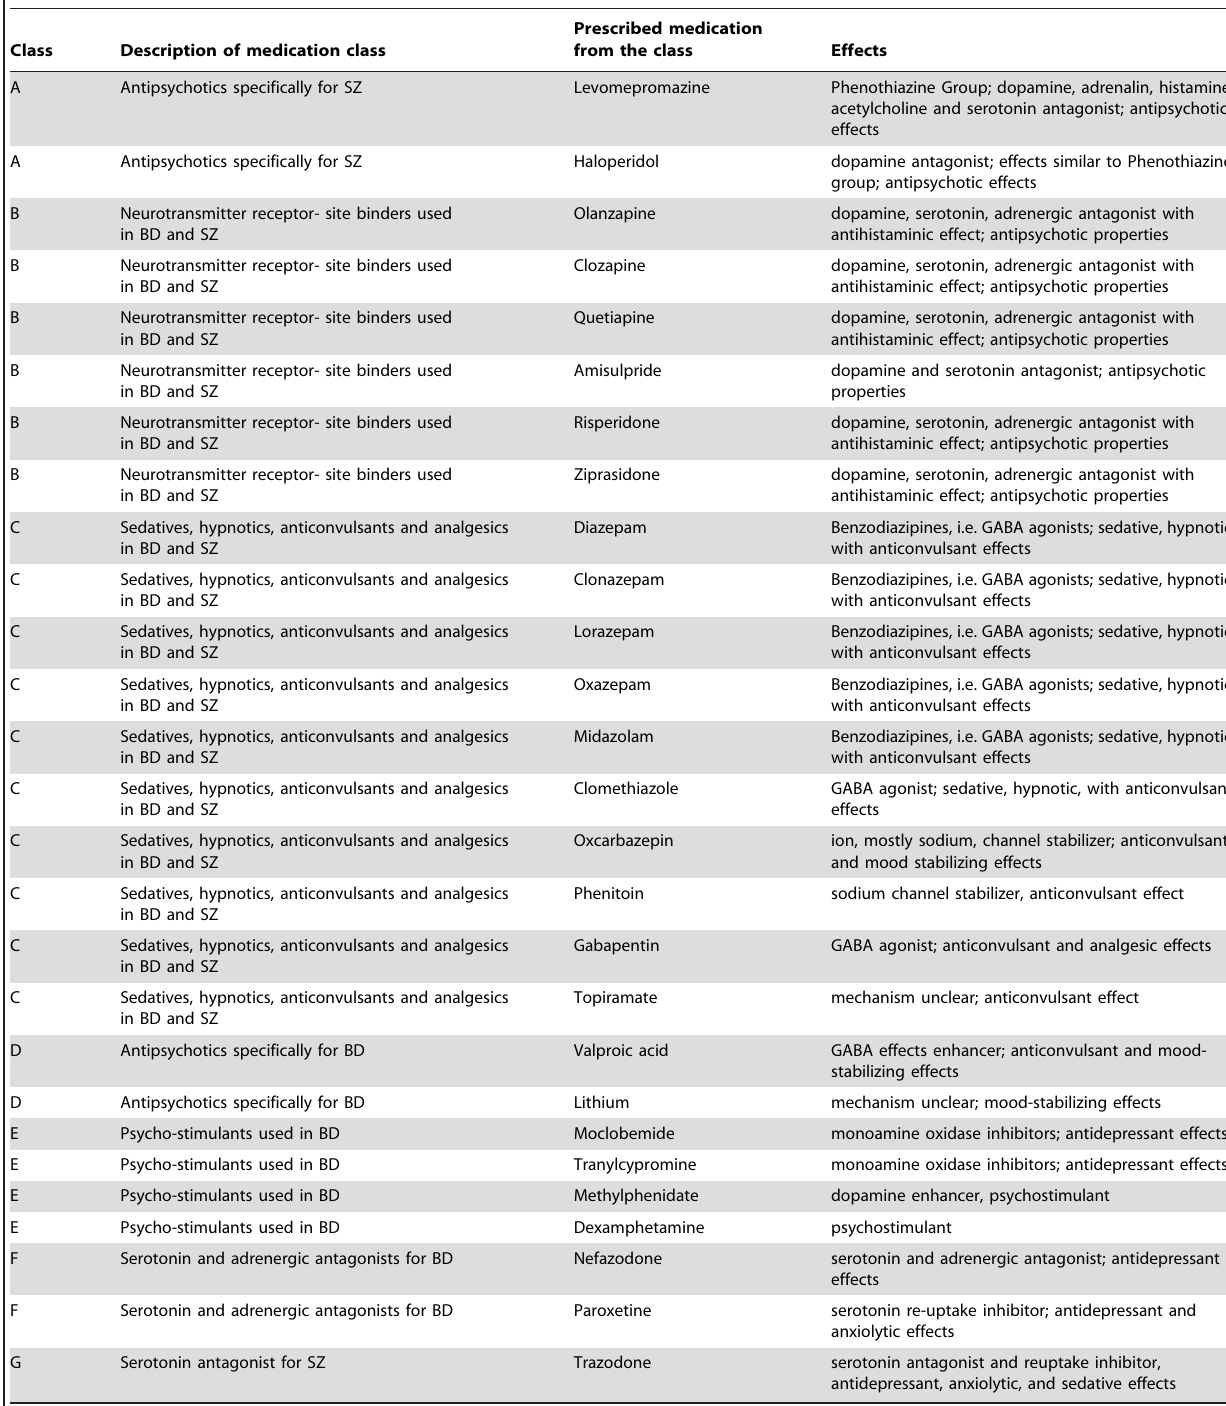
Table 5. Classes (A–G) encompassing the medications in Table